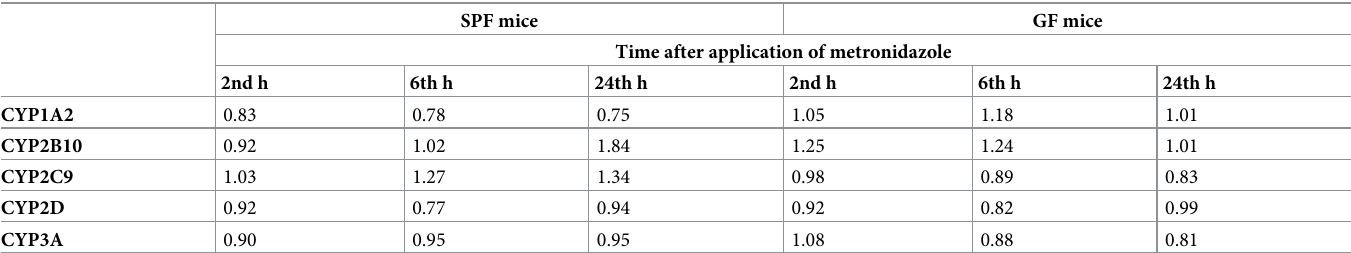
Table 2. Relative protein expression (western blotting) of selected CYP forms. Protein expressions at t = 0 h taken as control (equal to 1.00).